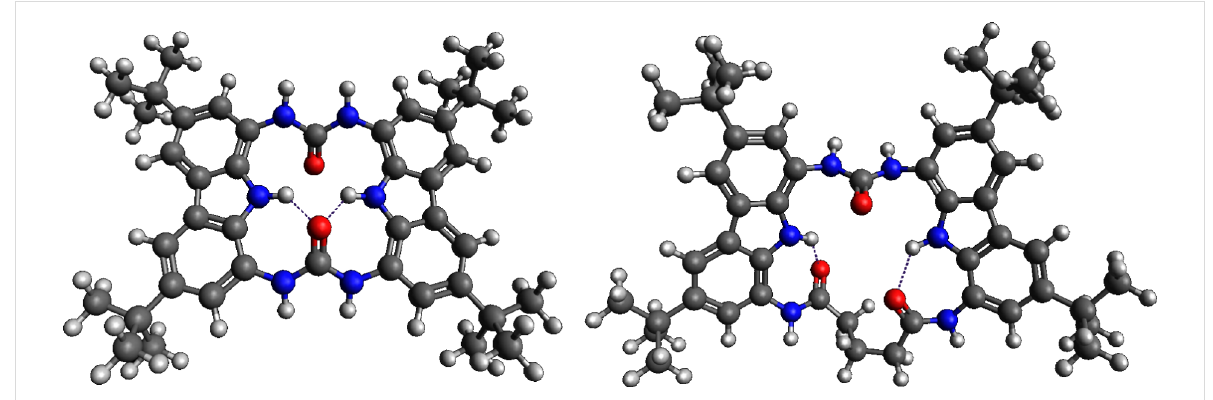
Figure 4: MC001 and MC003 lowest energy conformers (COSMO-RS) showing intramolecular bonds. Color coding: white – hydrogen; green – car- bon; blue – nitrogen; red – oxygen.